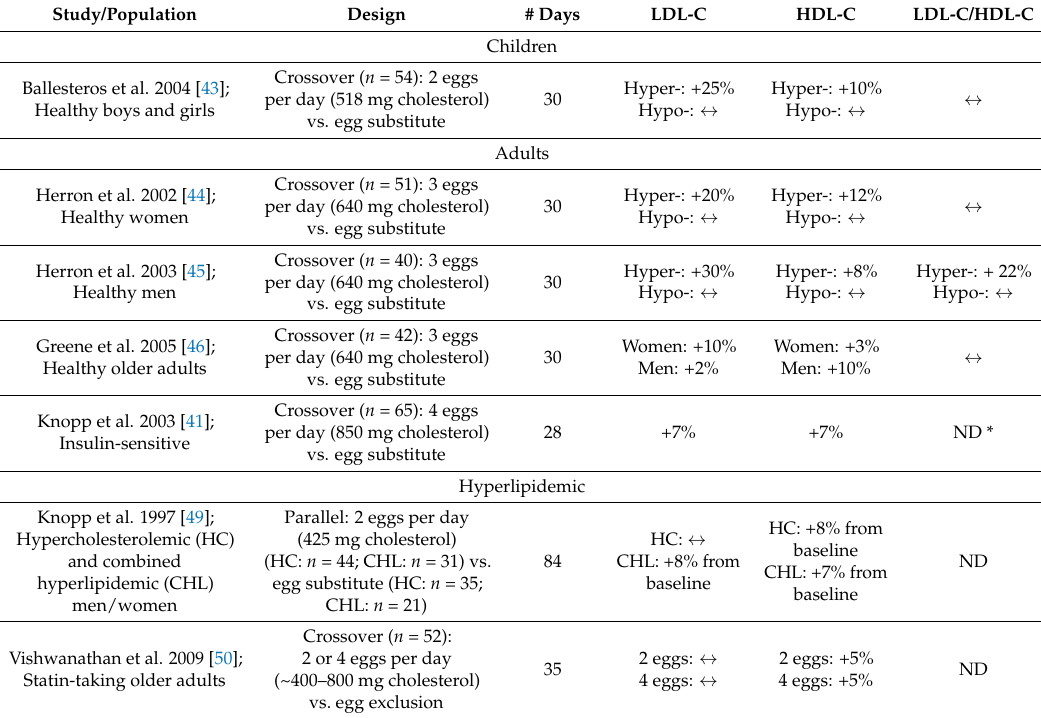
Table 1. Effects of additional dietary cholesterol from egg intake on serum lipids during weight maintenance: healthy and hyperlipidemic